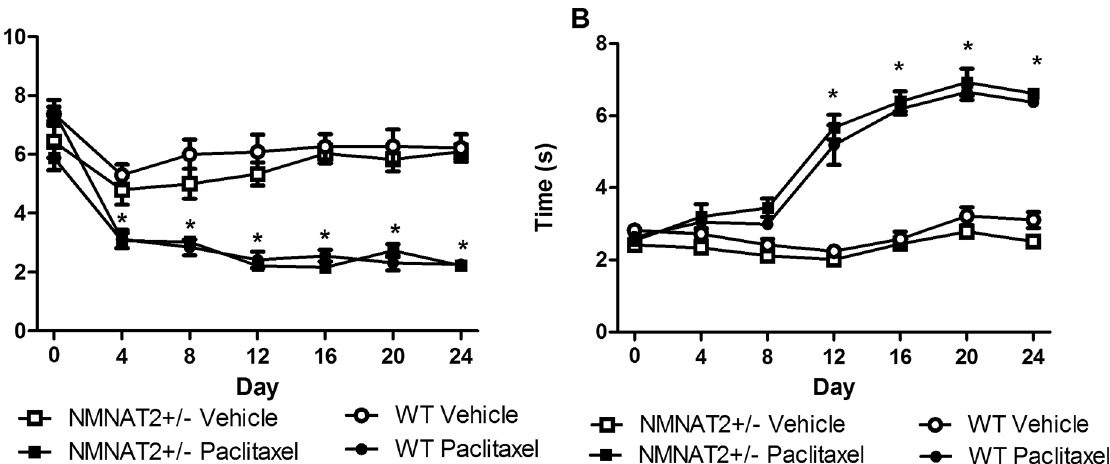
Fig 5. Paclitaxel-induced mechanical and cold allodynia did not differ between NMNAT2+/- and WT mice. There were no differences between genotypes in the development or maintenance of paclitaxel-induced mechanical hypersensitivity (A) or cold allodynia (B). (NMNAT2 +/-vehicle n = 8; NMNAT2+/- paclitaxel n = 8; WT vehicle n = 5; WT paclitaxel = 5) * p < .05 vs. control, one-way analysis of variance followed by Bonferroni post hoc test.